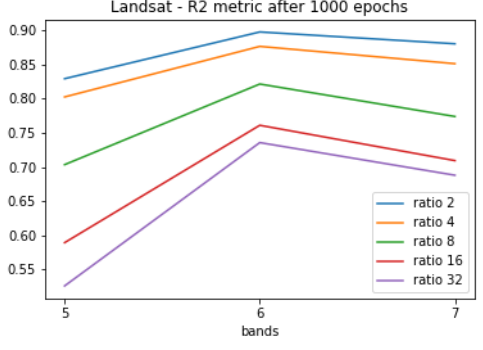
Figure 10. R 2 test set correlation metric for the Landsat test set.